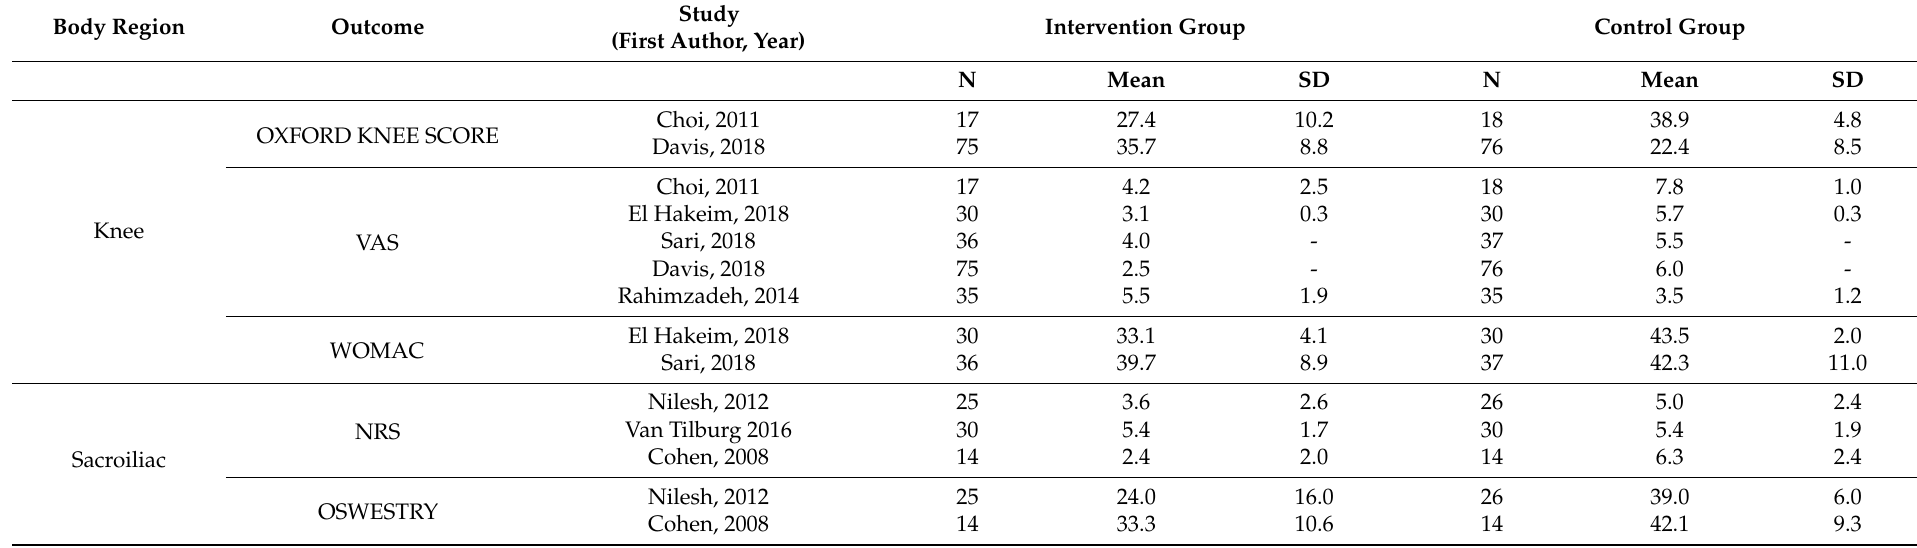
Table 2. Summary on the outcome measures according to body